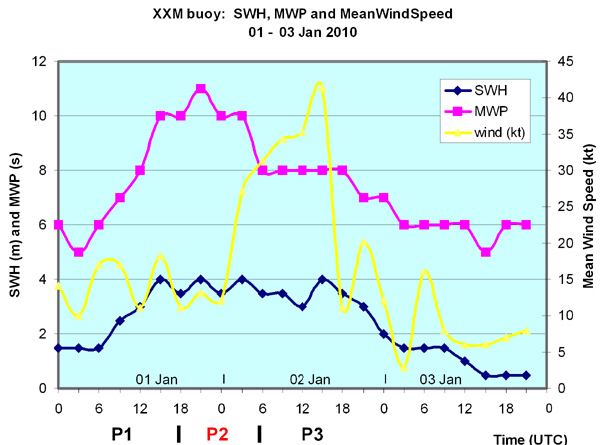
Figure 3. 1–3 January 2010 (hours in UTC) XXM buoy time-serie. Blue line indicates SWH (m), purple line MWP (s), yellow line 10m wind speed (kt). P1 to P3 refers to the sea-storm di ff erent phases. P2 (in red) is the most damaging